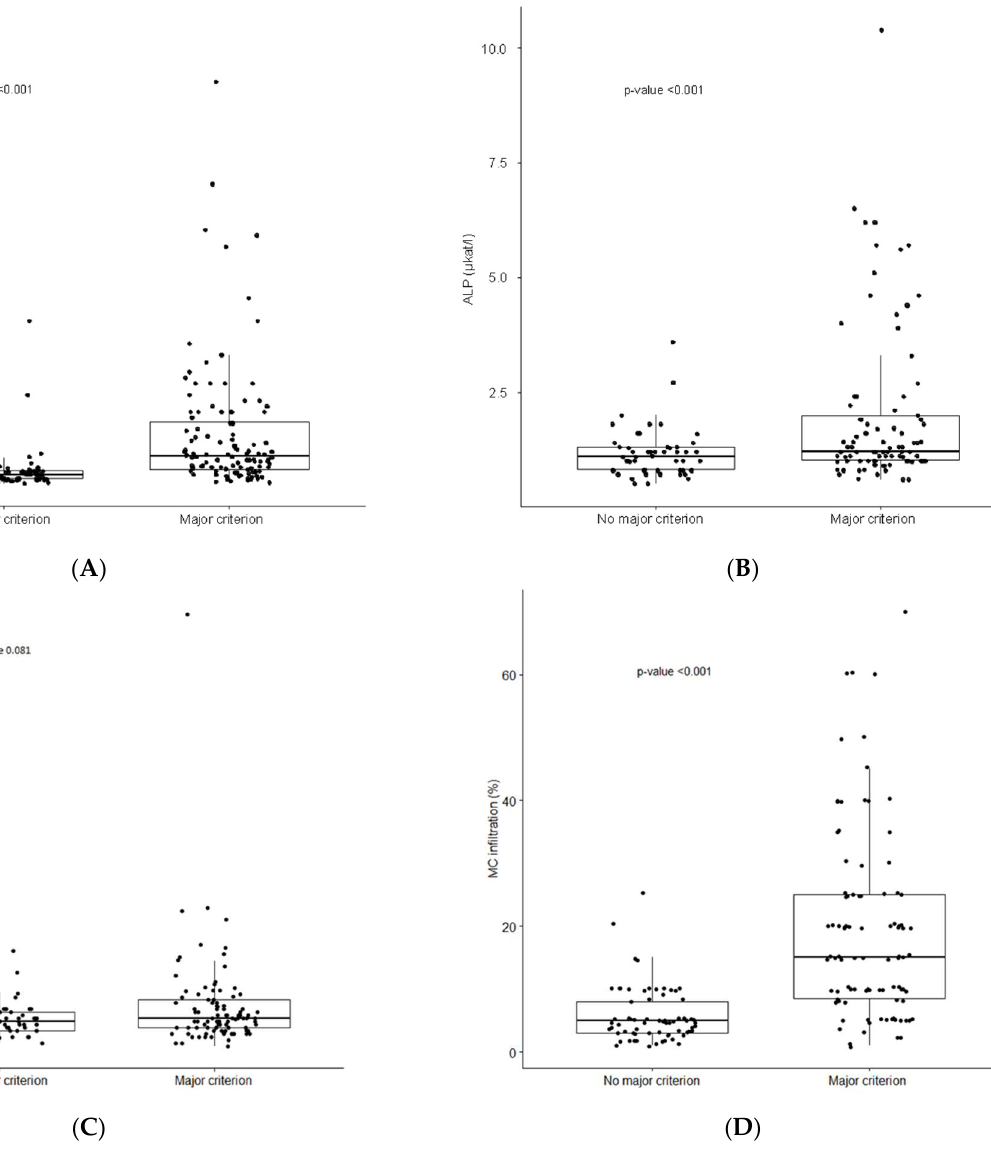
Figure 2. The relationships between the major criterion and tryptase, ALP, and B2M levels: Boxplots are used to explore relationships between the major criterion and ( A ) tryptase, ( B ) ALP, ( C ) B2M, and ( D ) MC infiltration; p -values were calculated using the Mann–Whitney U -test. Abbreviations: SM, systemic mastocytosis; ALP, alkaline phosphatase; B2M, beta-2-microglobulin.